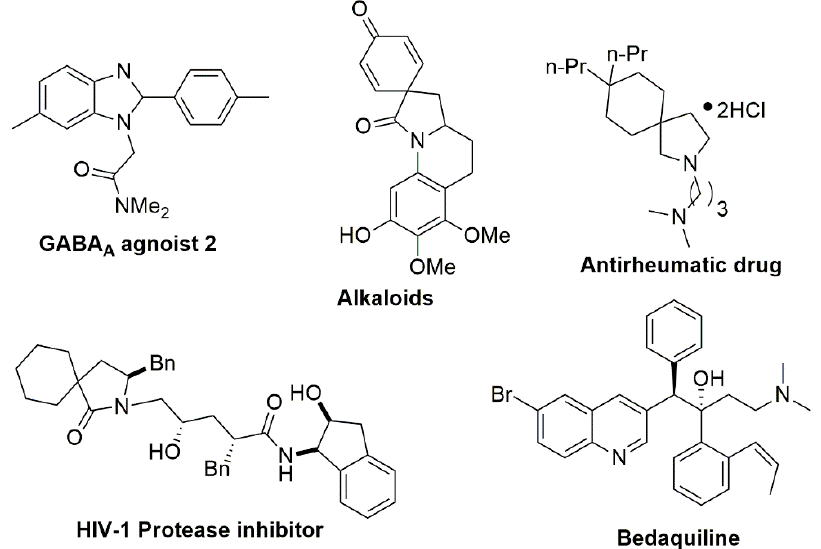
Figure 1. Synthesis of biologically active compounds through C-H/N-H bond